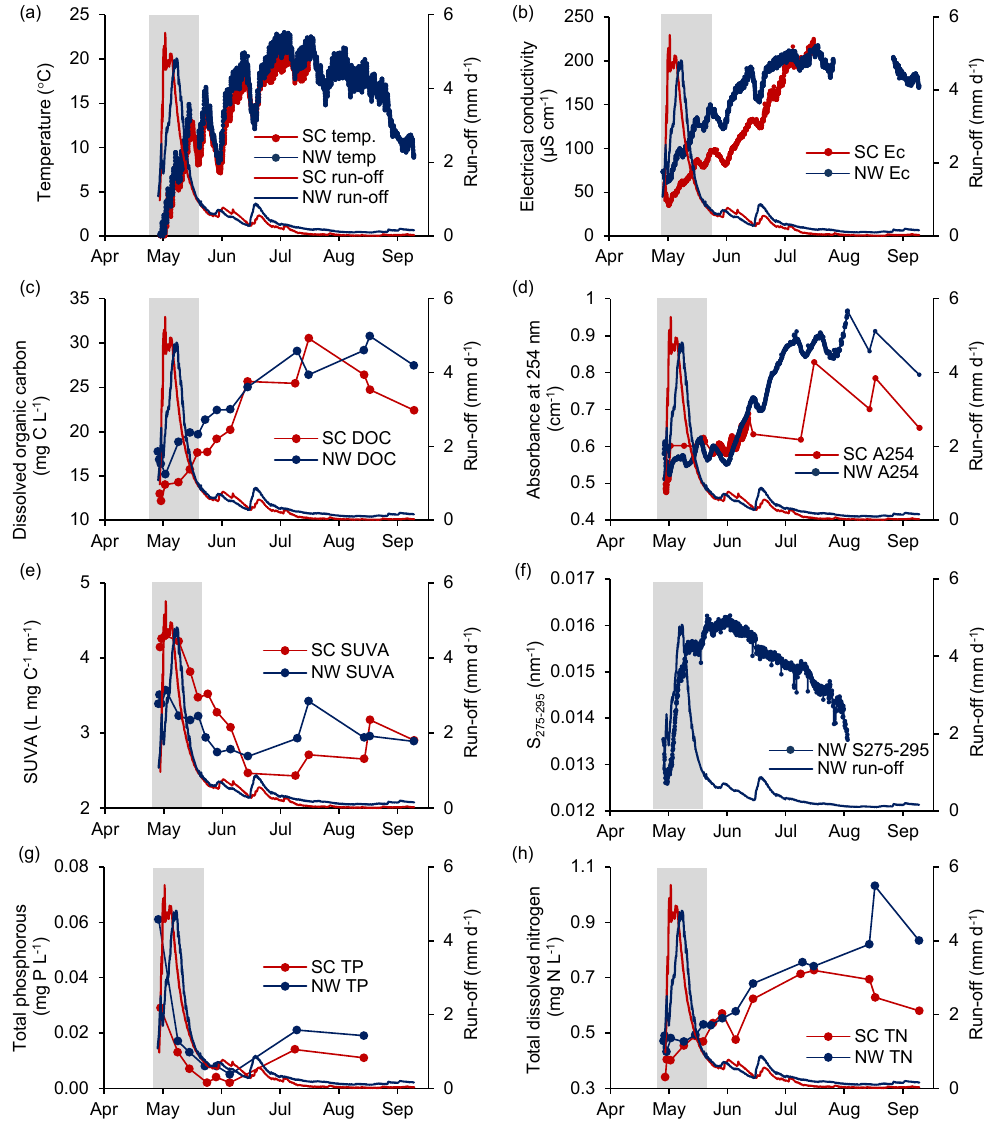
Figure 4. Seasonal variation in catchment run-off and stream water chemistry measured at the outlets of Scotty Creek catchment and the recently burned Notawohka Creek catchment, NT, Canada. Showing (a) temperature ( ◦ C), (b) electrical conductivity (µScm − 1 ) , (c) DOC concentration (mgCL − 1 ) , (d) A 254nm (cm − 1 ) , (e) SUVA (LmgC − 1 m − 1 ) , (f) S 275–295 , (g) total phosphorous (mgPL − 1 ) , and (h) total dissolved nitrogen (mgNL − 1 ) . The shaded grey area indicates the spring period (29 April–26